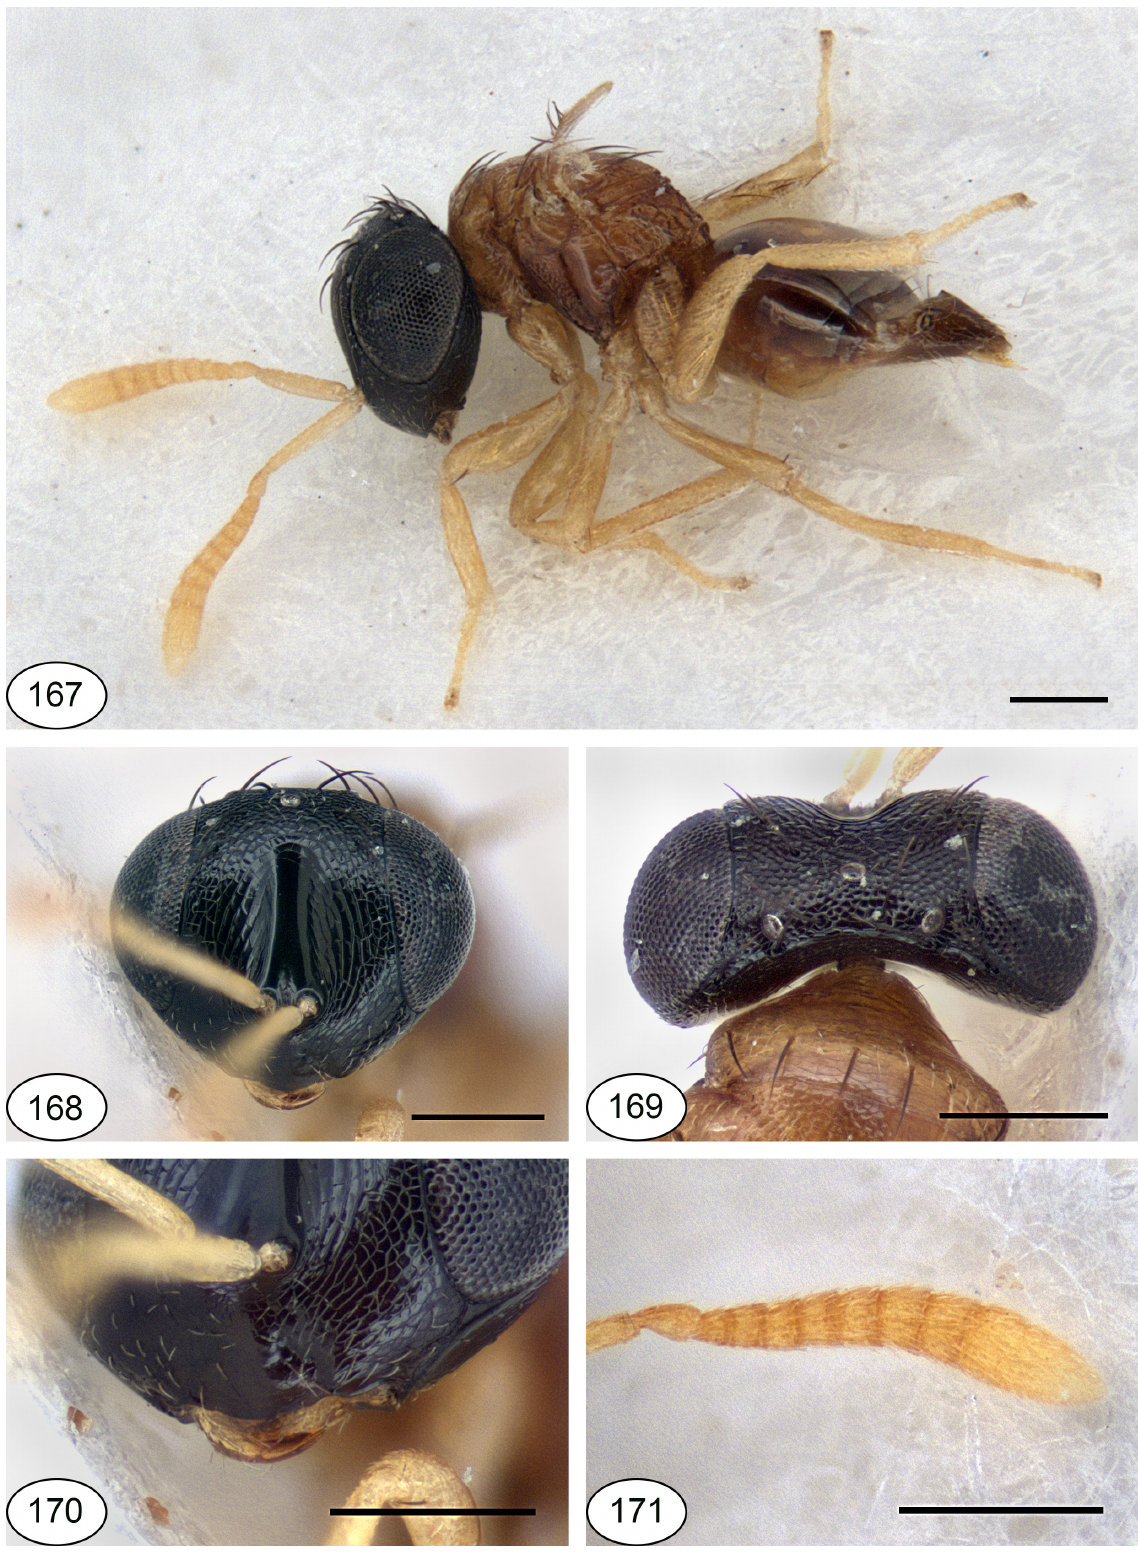
Figs 167–171. Netomocera sedlaceki Bouček, 1988, paratype, ♀, (BMNH). 167 . Habitus, lateral view. 168 . Head, frontal view. 169 . Head, dorsal view. 170 . Lower face. 171 . Antenna. Scale bars: 0.2